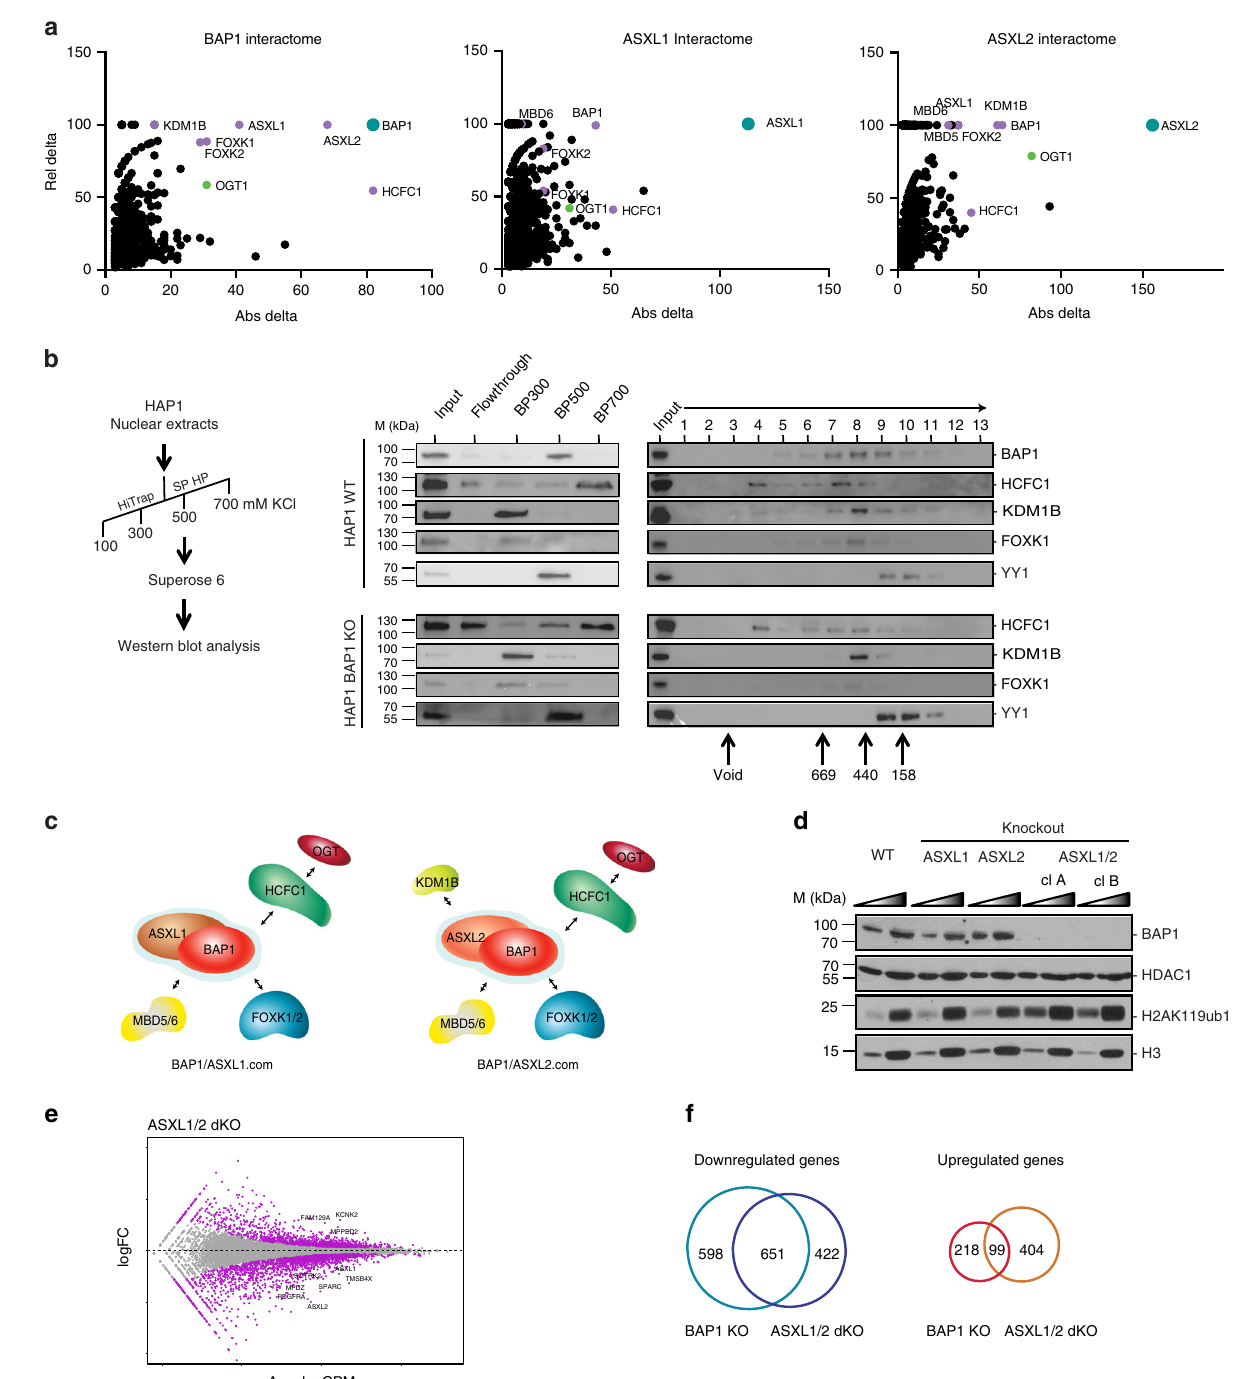
Fig. 2 BAP1.com core complex and associated factors. a Mass spectrometry analysis of HeLa cells overexpressing Flag-tagged versions of BAP1, ASXL1, and ASXL2. Graphs represent proteins relative to their absolute (Abs) and relative (Rel) delta compared with mass spectrometry analysis of empty vector expressing cells. Absolute delta is the absolute difference between distinct peptides identi fi ed in sample and control; relative delta is the ratio of absolute delta versus the sum of distinct peptides identi fi ed in sample and control. b Elution patterns of HAP1 WT and HAP1 BAP1 -KO nuclear extracts following the puri fi cation scheme indicated in the left panel and monitored by western blot with the indicated antibodies. Middle pattern is a representative elution pattern (step elution with increased salt concentration) on a cation exchange column (SP-HP, GE). Right panel is a representative elution pattern on a size- exclusion column (Superose 6, PC3.2/30, GE) . Underneath is the correspondent . c Schematic of BAP1.com core complex and associated factors depending on the ASXL paralog present. d Western blot analysis of BAP1 and H2AK119ub1 in the different KO conditions indicated above. Two independent clones of ASXL1/2 dKO cells are shown. HDAC1 and H3 serve as nuclear and histone protein loading control respectively. A two-point titration (1:2.5 ratio) is shown for each condition. e Scatterplot showing log2 fold-change (logFC) expression between wild-type and ASXL1/2 dKO cells as a function of average log2 counts per million (logCPM). Differentially expressed genes in ASXL1/2 dKO cells are highlighted in purple. f Venn diagram showing the overlap between genes downregulated 60 or upregulated (right) in BAP1 KO and ASXL1 /2 dKO